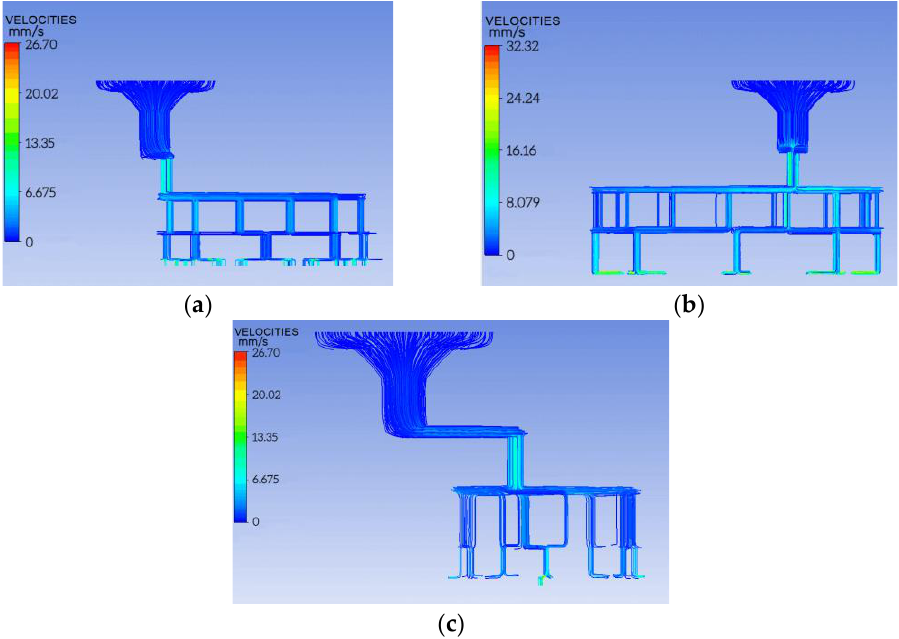
Figure 3. Velocity distribution of three components. ( a ) Component A; ( b ) component B; ( c ) compo- nent C.